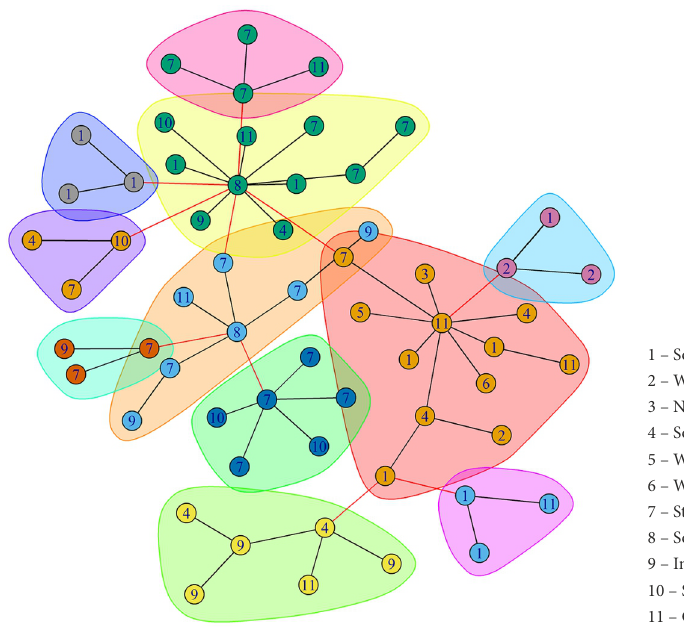
Figure 4. Community structures of new energy